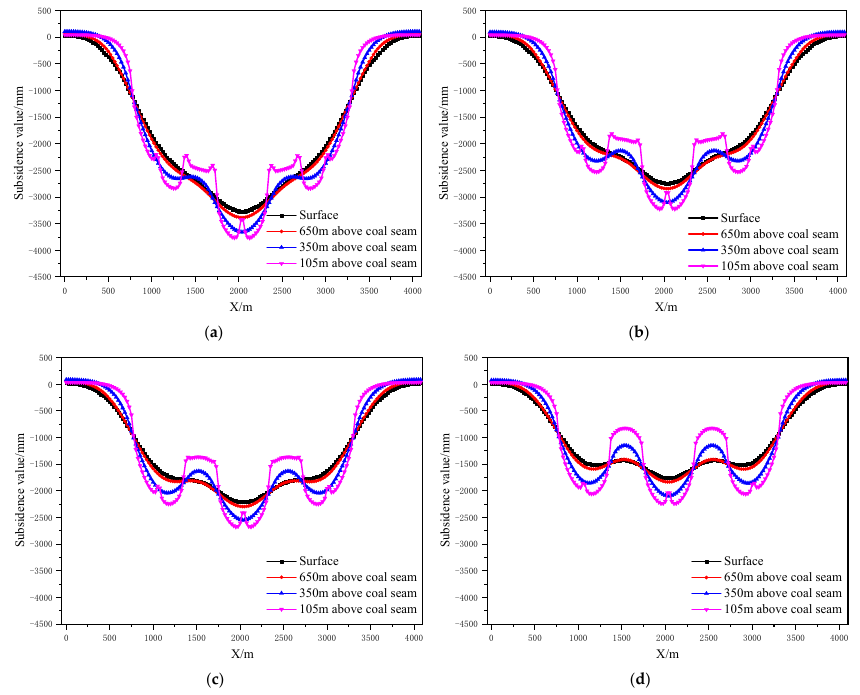
Figure 7. Strata and surface subsidence laws of partial filling mining based on the main key stratum under different filling ratios; ( a ) filling ratio = 60%. ( b ) Filling ratio = 70%. ( c ) Filling ratio = 80%. ( d ) Filling ratio = 90%.